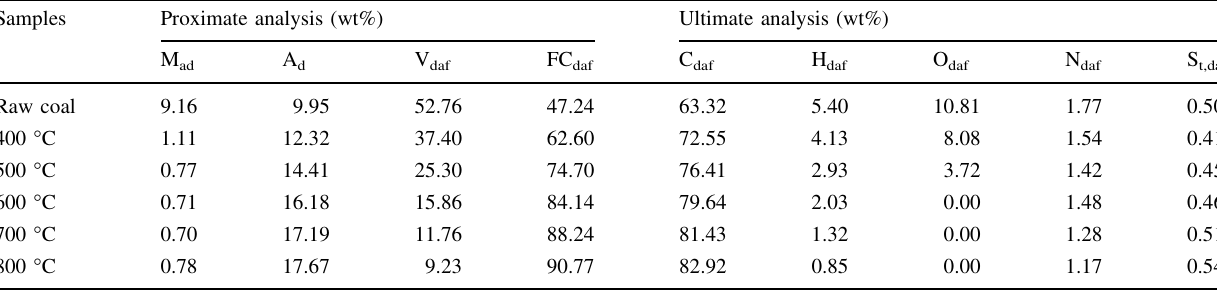
Table 4 Characteristics of raw MZH coal and chars pyrolyzed in different temperatures